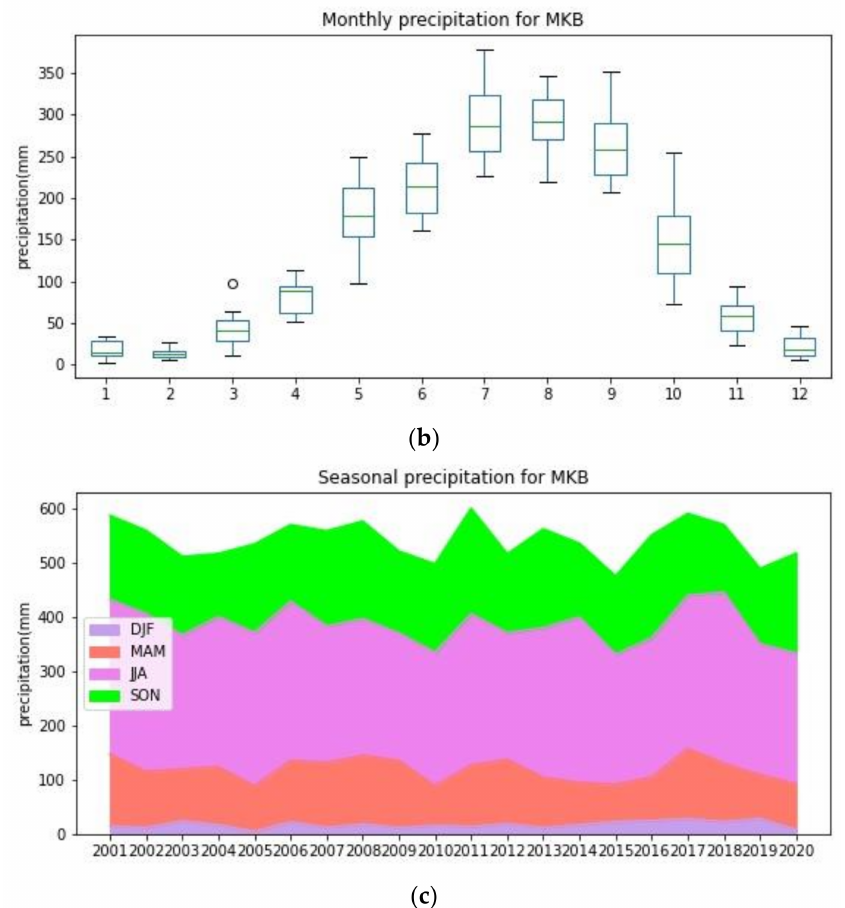
Figure 4. The lowest average monthly precipitation ( a ), monthly ( b ), and seasonal ( c ) precipitation of the MKB with DJF (December, January, February), MAM (March, April, May), JJA (June, July, August), and SON (September, October, November). Rainfall in the MKB is not distributed differently between the upstream and down- stream (Figure 5). However, in general, the climate in the MKB can be divided into two seasons: the rainy season and the dry season. The rainy season is from June to November, and the dry season is from November to May. This result is similar to the study by Lee and Dang [35]. Based on the analysis results, the IMERG satellite data were applied to the meteorological spatial analysis and spatial analysis for the MKB